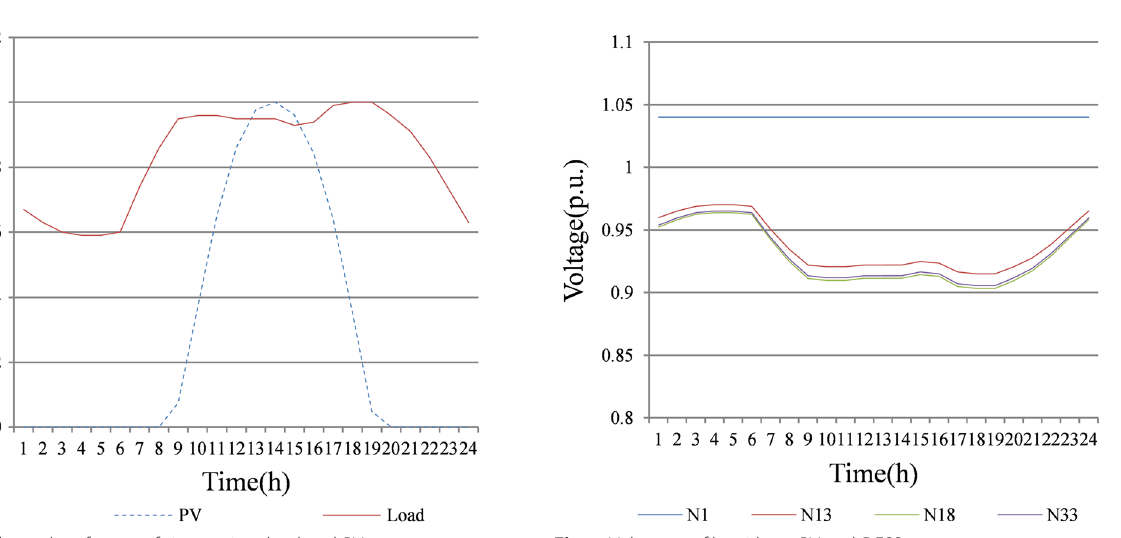
Fig. 4 The scaling factors of time-variant load and PV Fig. 5 Voltage profile with no PV and